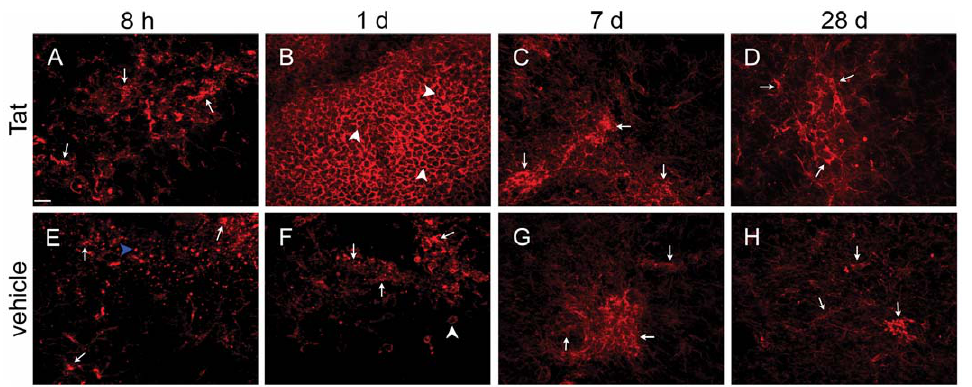
Figure 1. HIV-1 Tat causes enduring microglial activation and transient leukocyte infiltration into hippocampal neuropil. Both microglia and leukocytes were visualized with CD11b + and they could be distinguished by their morphology because infiltrating leukocytes had round or ovoid morphology whereas microglia had ramified, often hypertrophied processes. Wild-type mice received either Tat (top panels, n=3) or saline control vehicle (bottom panels, n=3) injection into the right hippocampus and were sacrificed 8 hours (Panels A and E), 1 (Panels B and F), 7 (Panels C and G) and 28 (Panels D and H) days later, and hippocampal tissue sections processed for CD11b immunocytochemistry as described in Methods. All microscopic fields depicted here are directly adjacent to the injection site. White arrows point to examples of ramified microglia and white arrowheads point to examples of round or ovoid infiltrating leukocytes. The blue arrowhead in E points to a microglial cell fragment that was frequently seen in both the Tat and saline treatment groups 8 hours after injection. These cellular fragments typically appeared as isolated globules scattered in and around the injection site but were much smaller than leukocytes. Scale bar=16 m m for all micrographs.